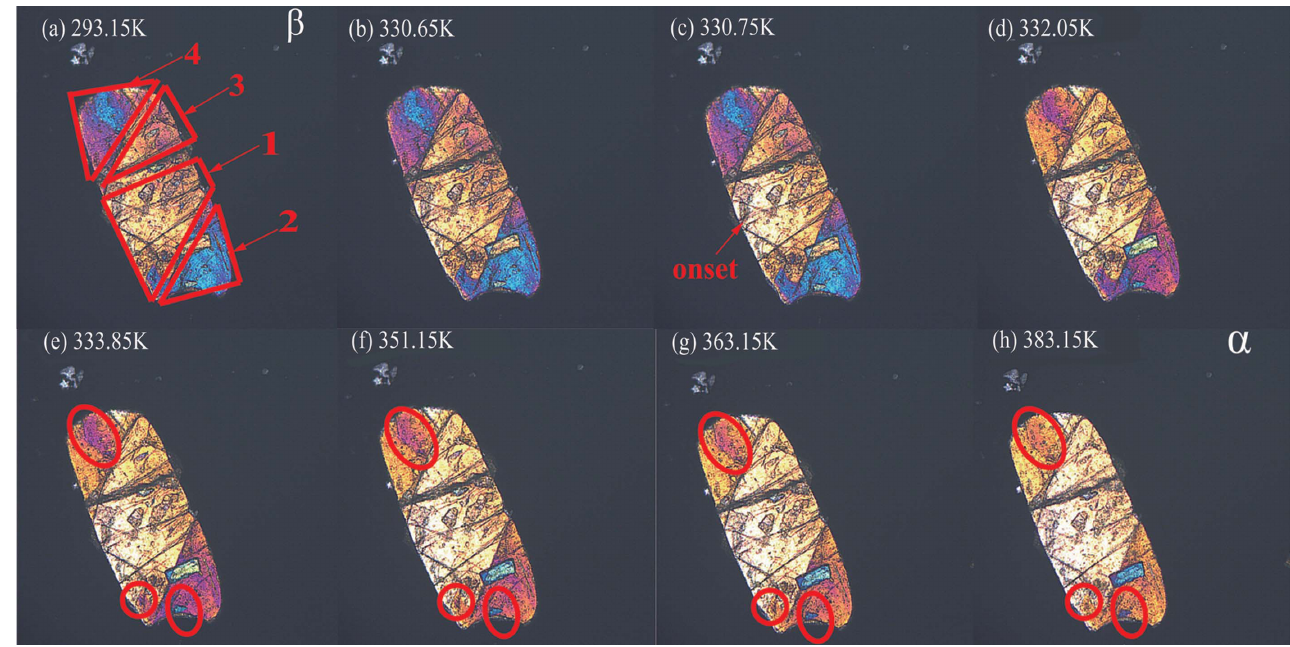
Figure 7 HS-POM images of the polycrystalline powders after milling for 30 min showing the change in polarization colour at different defect density zones during the heating process. ( a ) HS-POM image of the pure (cid:3) form, ( b )–( d ) rapid first-step phase transition, ( d )–( h ) slow second-step phase transition [crystals in ( h ) are (cid:2) form]. Defect areas are marked by red